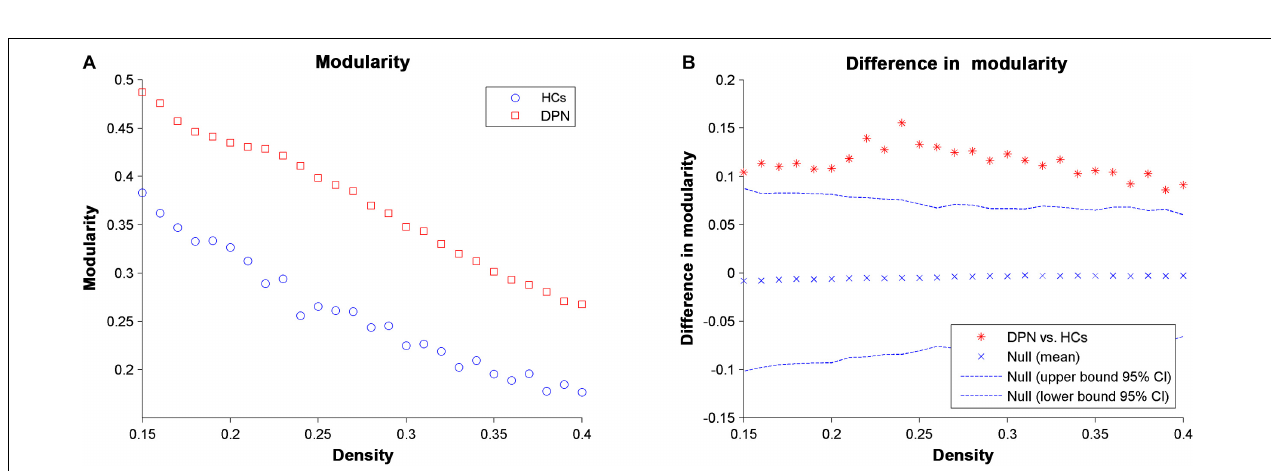
FIGURE 4 | Changes in modularity (A) and between-group differences in modularity (B) as a function of network density. The ∗ marker denotes the difference between HCs and DPN patients; the ∗ signs lying outside of the confidence intervals indicate the density where the difference is significant at P < 0.05.